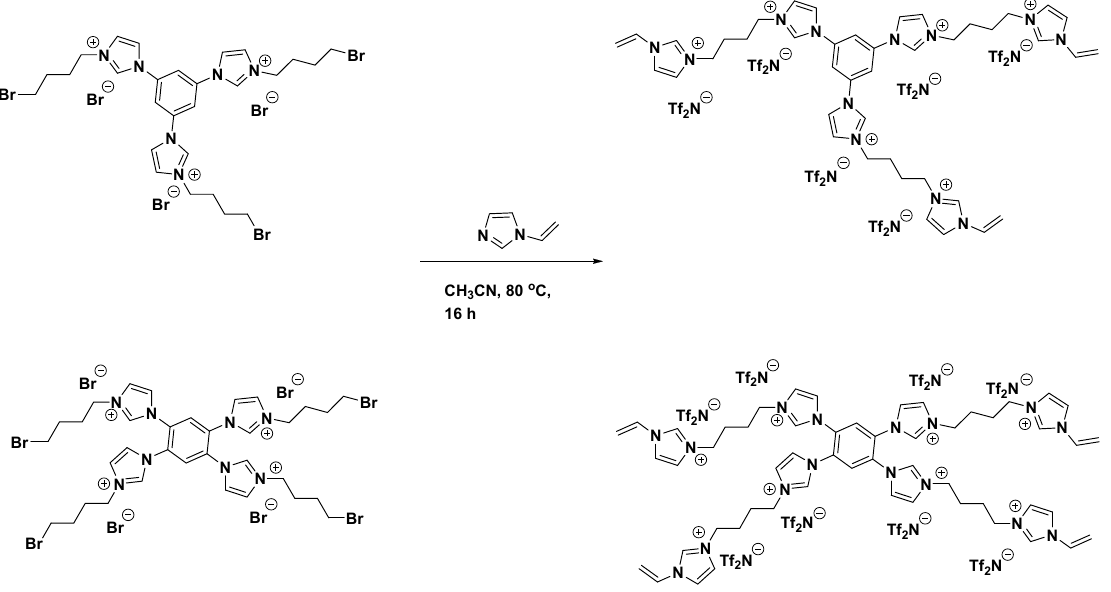
Scheme 3. Imidazolium-benzene derived tri- or tetra- vinylimidazolium crosslinking agents.